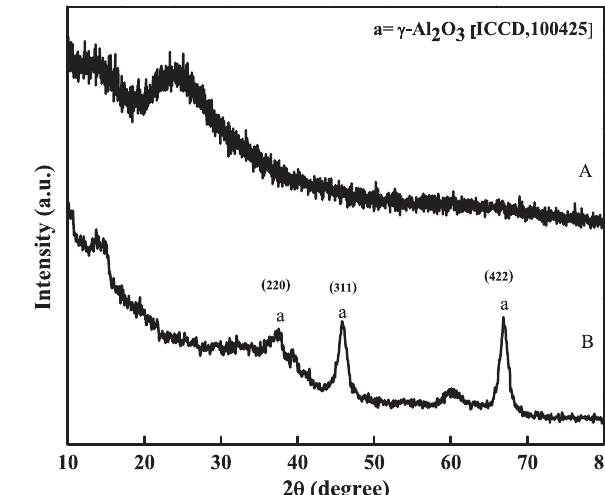
Fig. 8: XRD pattern of the particles, (A) calcined at 800 °C, (B) calcined at 1000